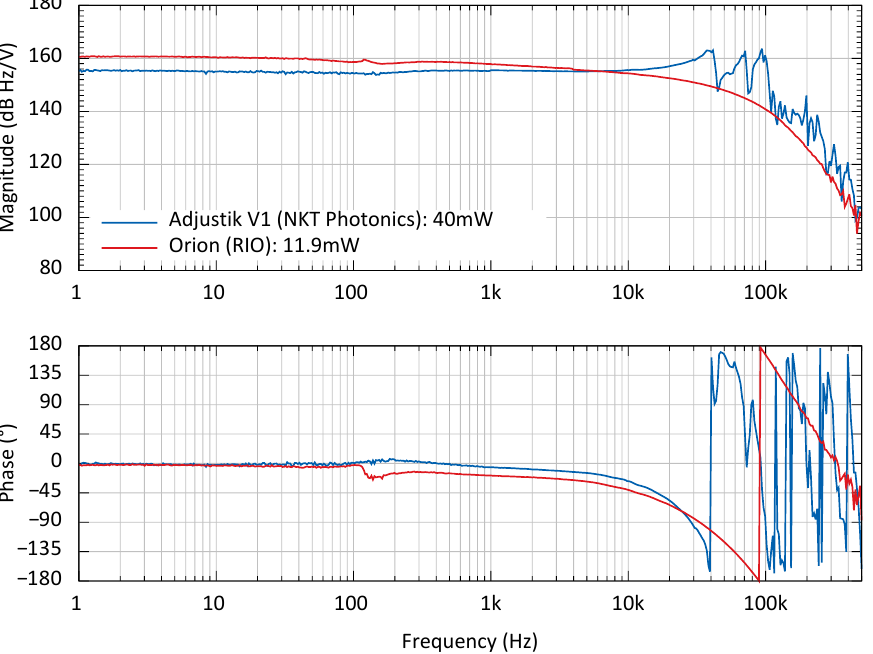
Figure 4. The frequency actuation transfer functions of the fiber laser and of the Orion laser show a similar magnitude at low frequencies. Resonances in the fiber laser’s transfer function reduce the usable actuation bandwidth significantly compared to the Orion laser.